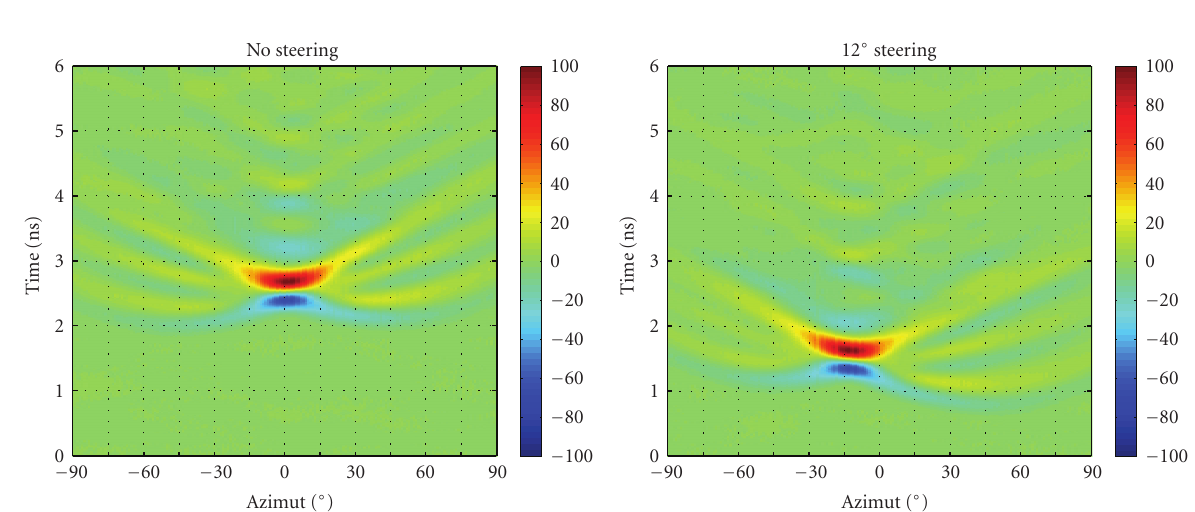
Figure 7: Transient radiation patterns in the